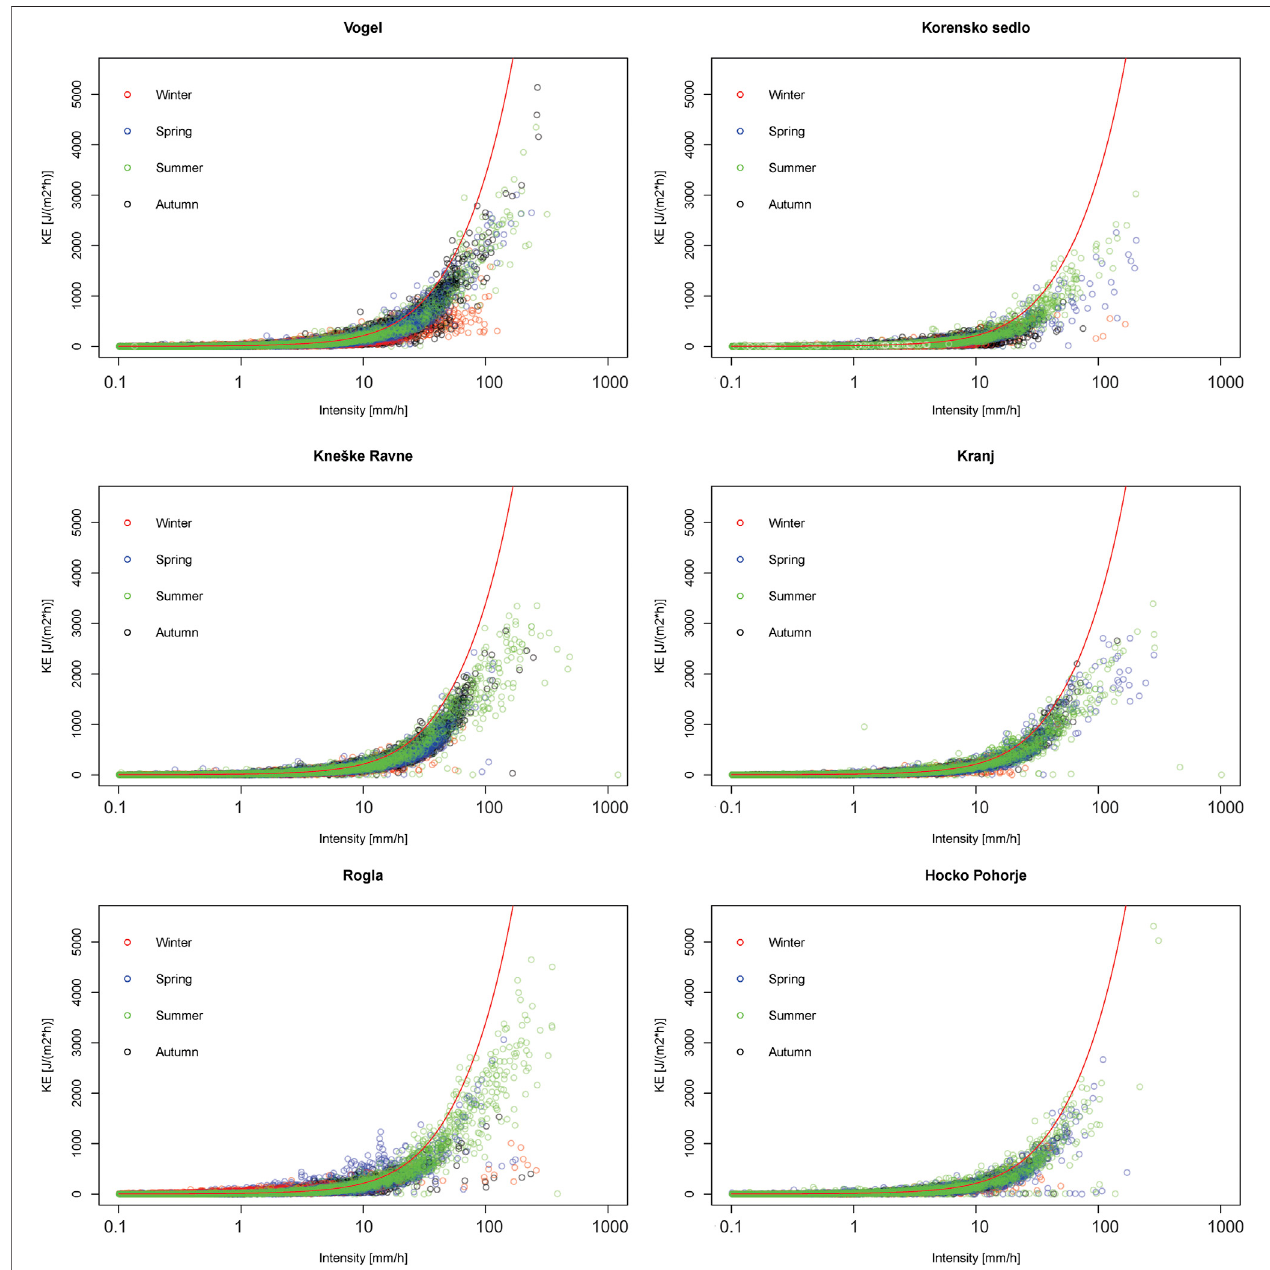
FIGURE 5 | 1 min KE-I relationship for six analyzed stations together with the KE-I function developed by Petan (2010) for Bovec station (i.e., red line).